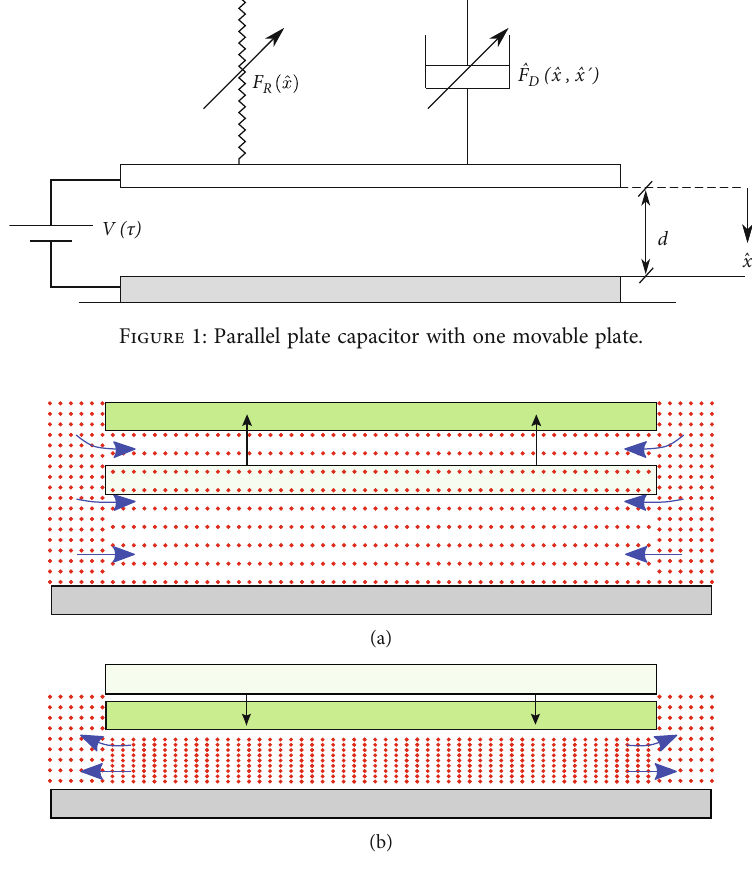
Figure 2: Squeeze fi lm damping on parallel plate